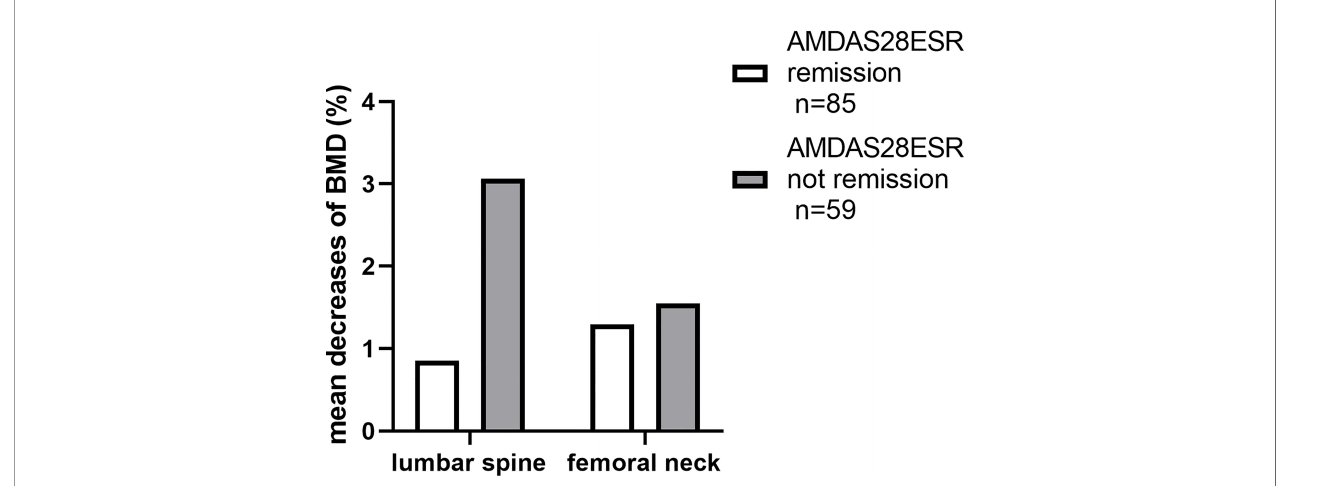
FIGURE 4 | The disparities in the decreases of BMD during the fi rst year.